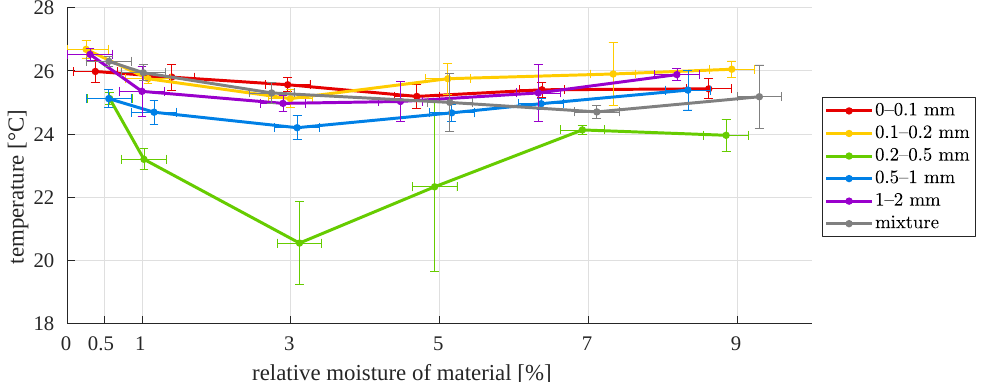
Figure 13. Surface temperature as function of relative moisture, for different particle sizes; first approach (macro images).